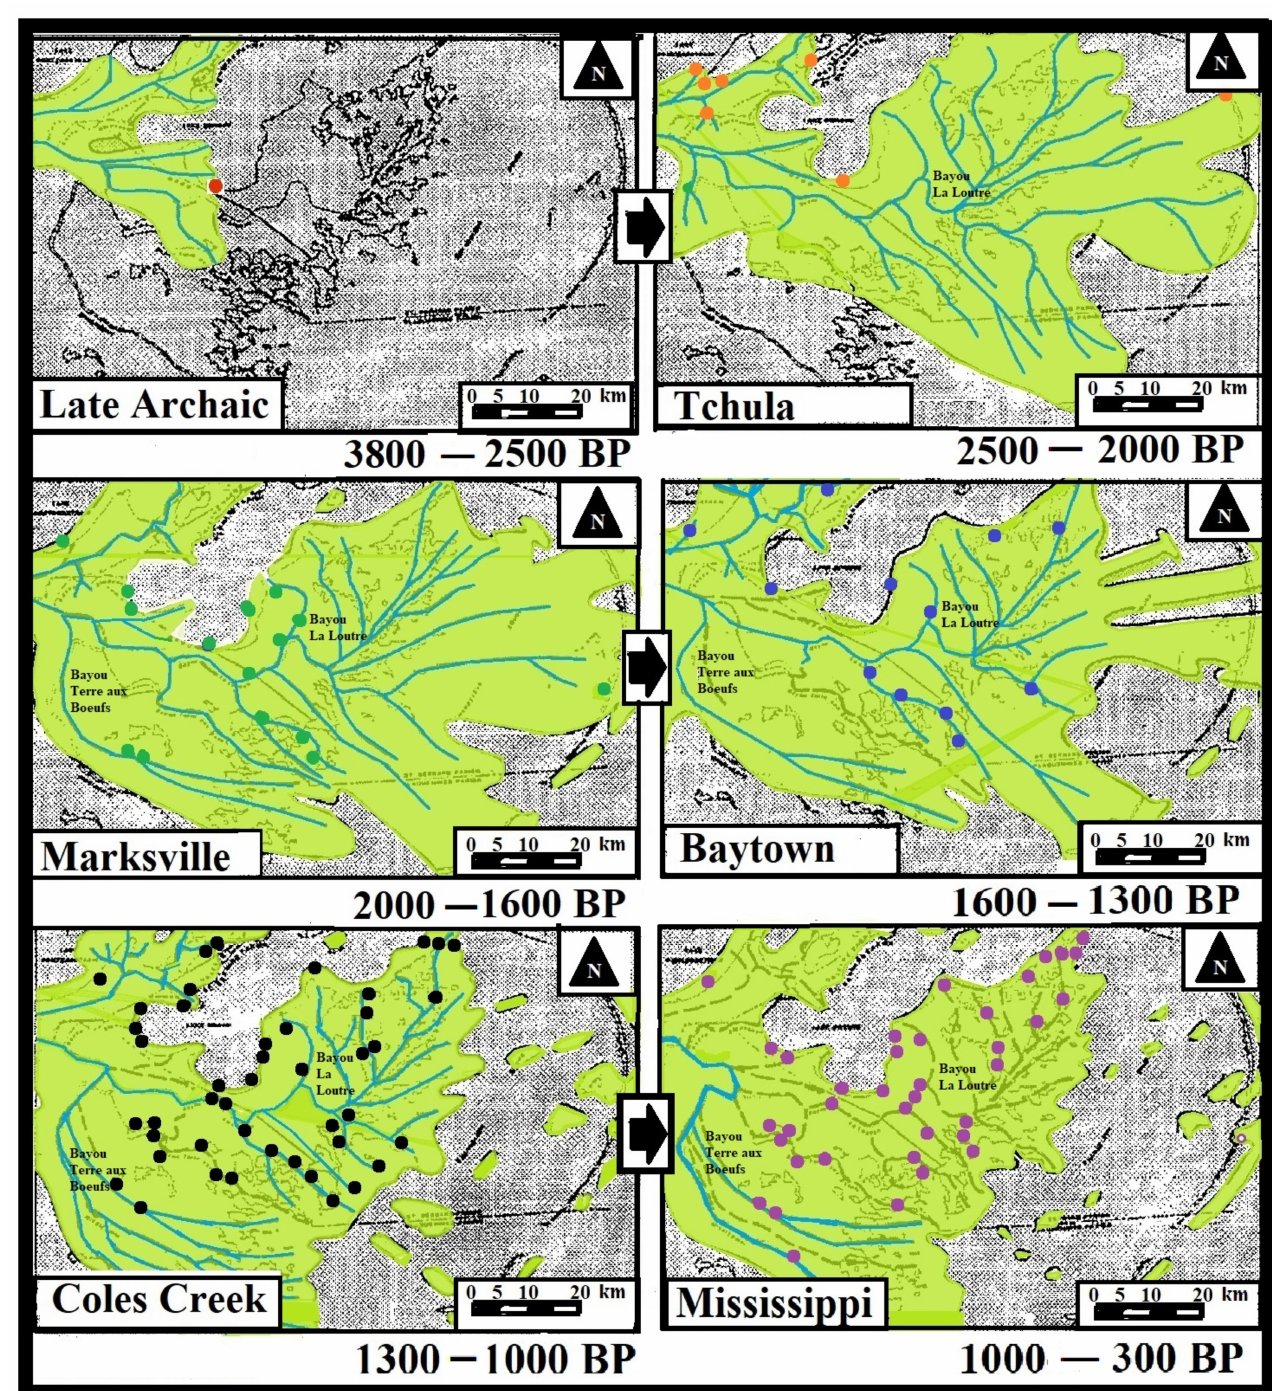
Figure 6. Sequence of St. Bernard sub-delta lobe development beginning 3.8 ka, and deterioration following abandonment about 1.8 ka, showing midden sites of usage by indigenous peoples during successive cultural phases prior to western contact. Adapted from Braud et al.